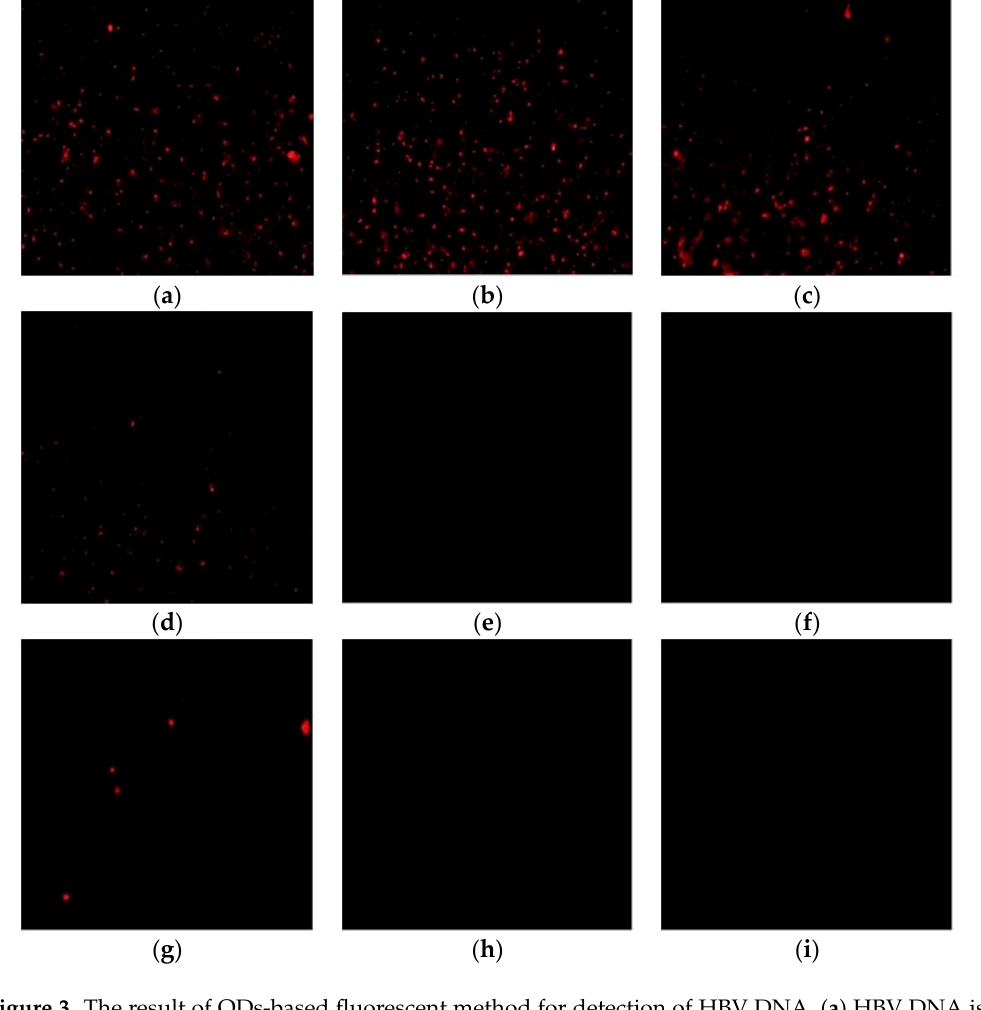
Figure 3. The result of QDs-based fluorescent method for detection of HBV DNA. ( a ) HBV DNA is 10 6 IU/mL with M204I mutation; ( b ) HBV DNA is 10 5 IU/mL with M204I mutation; ( c ) HBV DNA is 10 4 IU/mL with M204I mutation; ( d ) HBV DNA is 10 3 IU/mL with M204I mutation; ( e ) HBV DNA is 10 2 IU/mL with M204I mutation; ( f ) HBV DNA is 10 1 IU/mL with M204I mutation; ( g ) HBV DNA is 10 6 IU/mL without M204I mutation; ( h ) HBV DNA is 10 6 IU/m with M204I mutation, but without streptavidin-QDs; and ( i ) ultra-pure water.